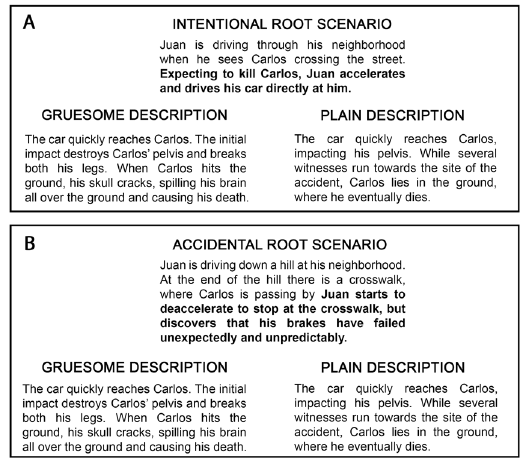
Fig. 1 Examples of stimuli for language manipulation. The top panel shows a stem scenario depicting intentional harm. The bottom panel presents a stem scenario depicting accidental harm. At the left side of each panel harm is described with gruesome terms, and at the right side harm is described with plain, just-the-facts language. Note that the consequence in each scenario is the same, namely,